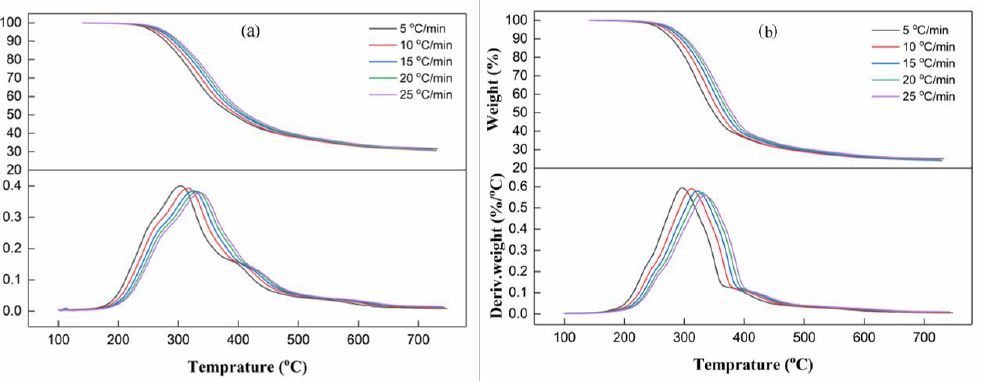
Figure 7. ( a ) TG and DTG curves of Chinese fir DEL at heating rates of 5, 10, 15, 20, and 25 °C/min; ( b ) TG and DTG curves of birch DEL at heating rates of 5, 10, 15, 20, and 25 °C/min.